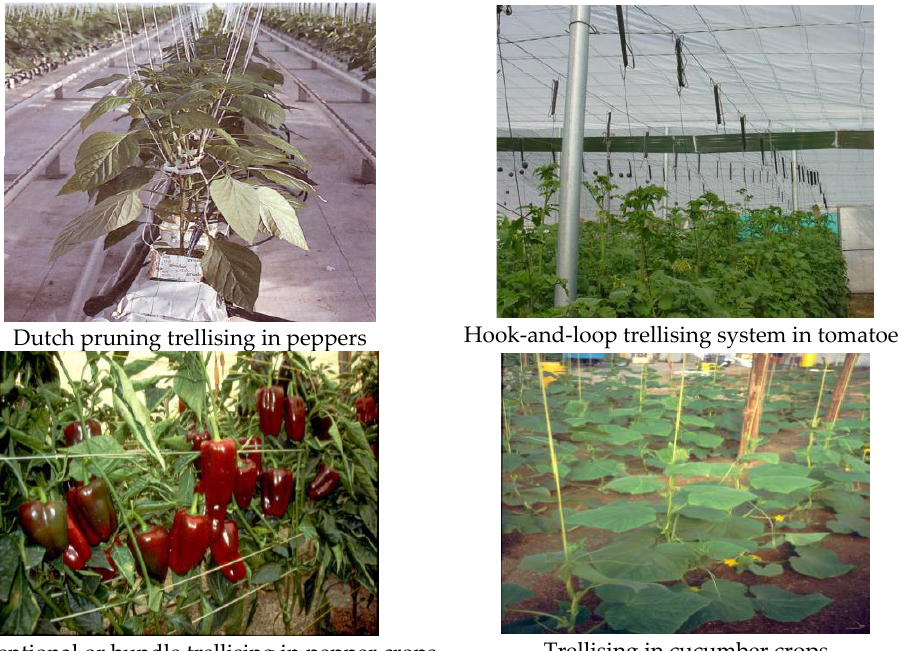
Figure 1. Trellising systems in the horticultural crops in Almería.